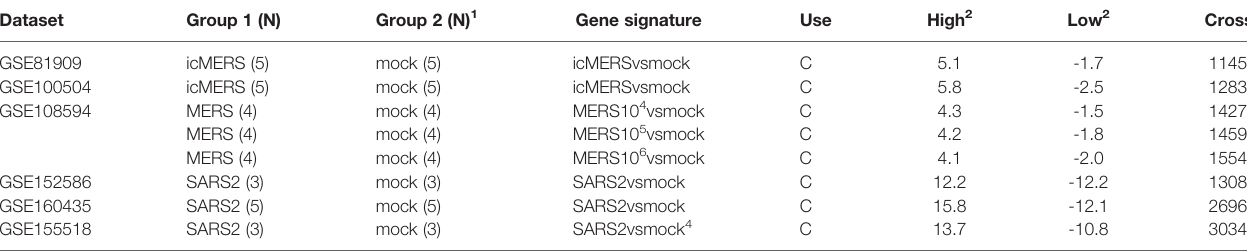
TABLE 3 | SARS-CoV Gene Signatures De fi ned in this Study. Dataset